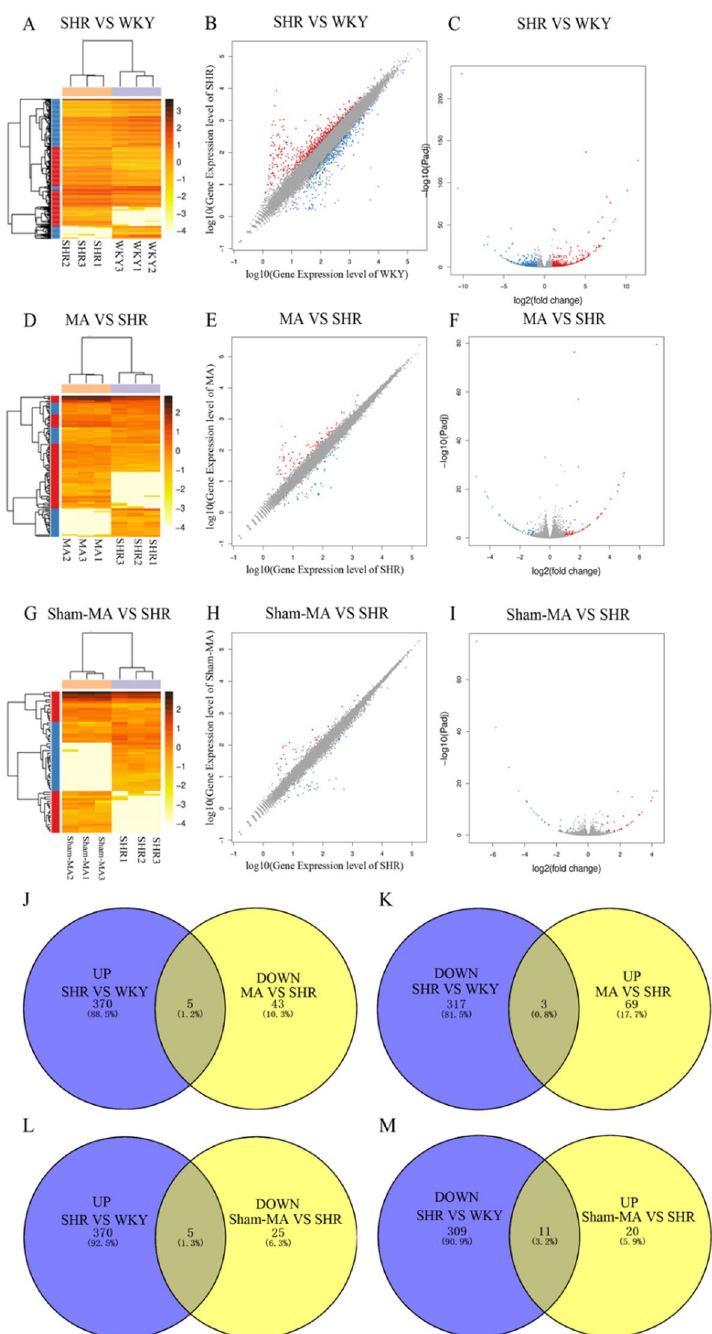
Figure 4. Significantly different mRNA expression in the PVH of WKY, SHR, MA and Sham-MA. The hierarchical clustering ( A , D , G ), scatter plot ( B , E , H ), and volcano plot ( C , F , I ) show differentially expressed genes (DEGs) between the WKY, SHR, MA and Sham-MA groups with the red and blue colors, respectively suggesting upregulated or downregulated expression; ( J – M ) Venn diagrams of the overlapping DEGs between groups are shown. Five genes increased in the SHR group but decreased in the MA group. Three genes decreased in the SHR group but increased in the MA group. The analysis of Volcano-plots, Scatter-plots and heatmaps were performed using R version 3.6.0 (https:// cran.r- proje ct. org/ bin/ windo ws/ base/ old/3. 6.0/). The overlap in upregulated and downregulated gene expression between the different groups was analysed using Venn